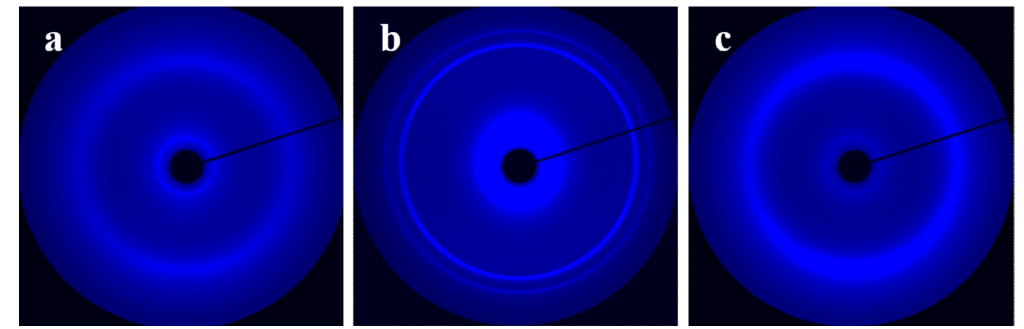
Figure 2. Wide-angle X-ray diffraction (WAXD) patterns of the high molecular weight poly( ε -caprolactone) H-PCL/poly(vinyl chloride) (PVC) blends cooled from 100 °C down to and kept at 40 °C for ( a ) 0 h and ( b ) 40 h. Part ( c ) was recorded after cooling from 100 °C down to 40 °C and then stretched immediately with a draw ratio of λ = 6 at a strain rate of 6 mm/min. The draw direction is horizontal.